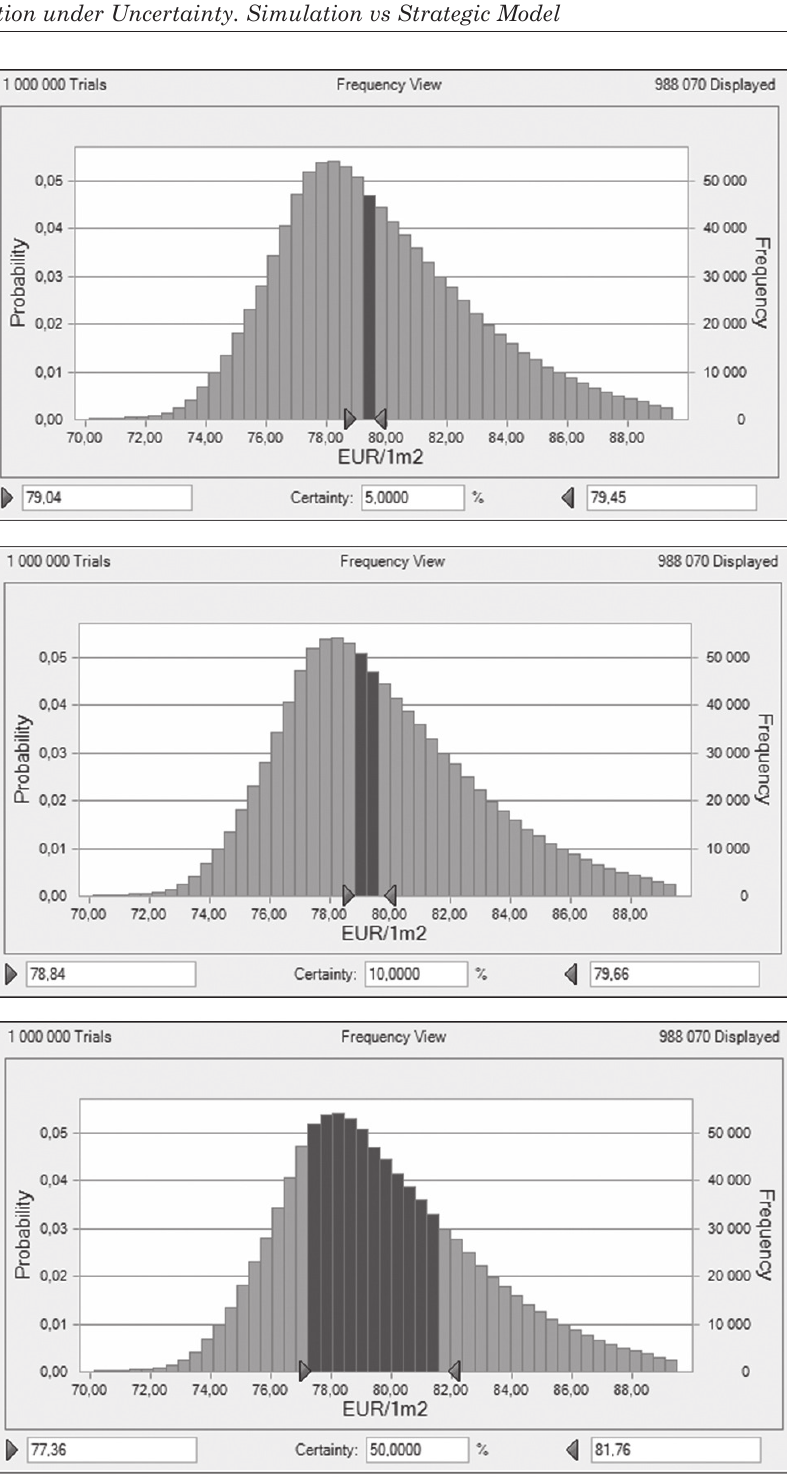
Figure 3. The certainty range at 5%, 10% and